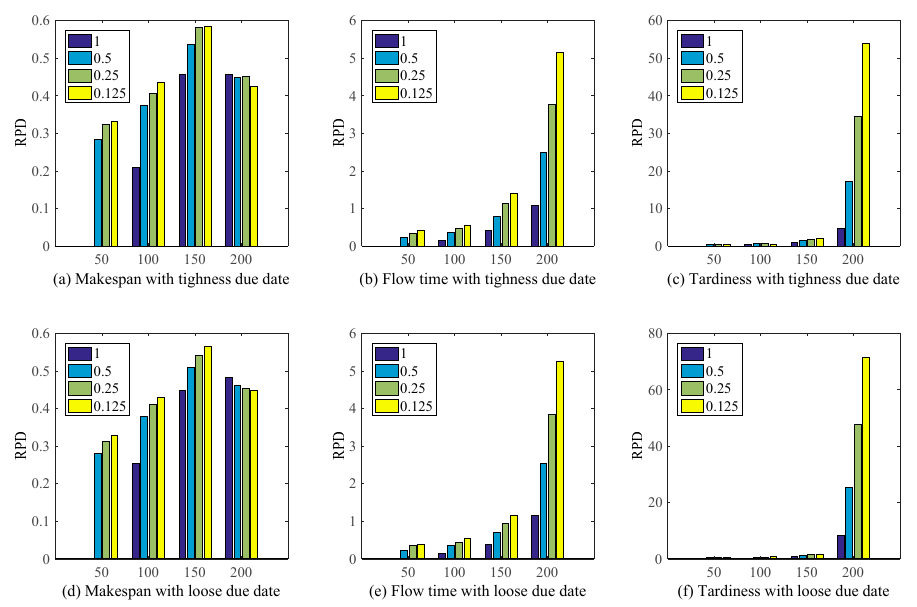
Figure 7. RPD for RH3 and IGEP under different scenario.